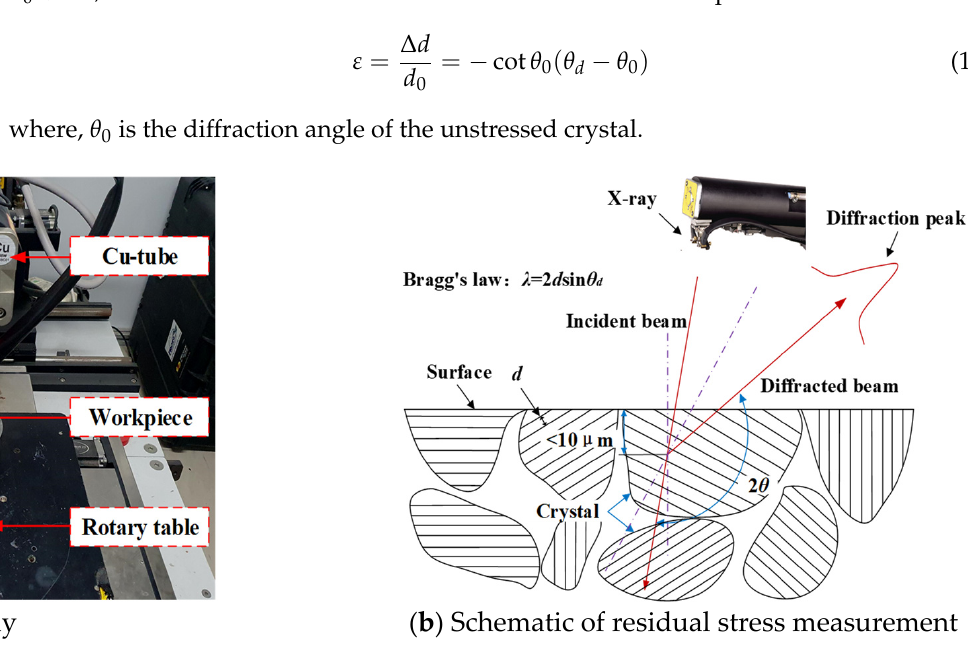
Figure 4. Residual stress measurement.